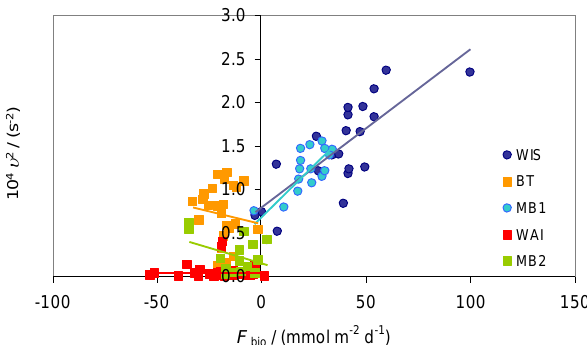
Fig. 6. Correlation between the square of the Brunt-V¨ais¨al¨a fre- quency (10 4 υ 2 ) and the biological oxygen flux ( F bio ) : dark and light blue circles represent the stations located in the WIS and MB1 areas (WSIZ); squares in orange, green and red are the stations for the BT, MB2 and WAI areas, respectively, in the POOZ.